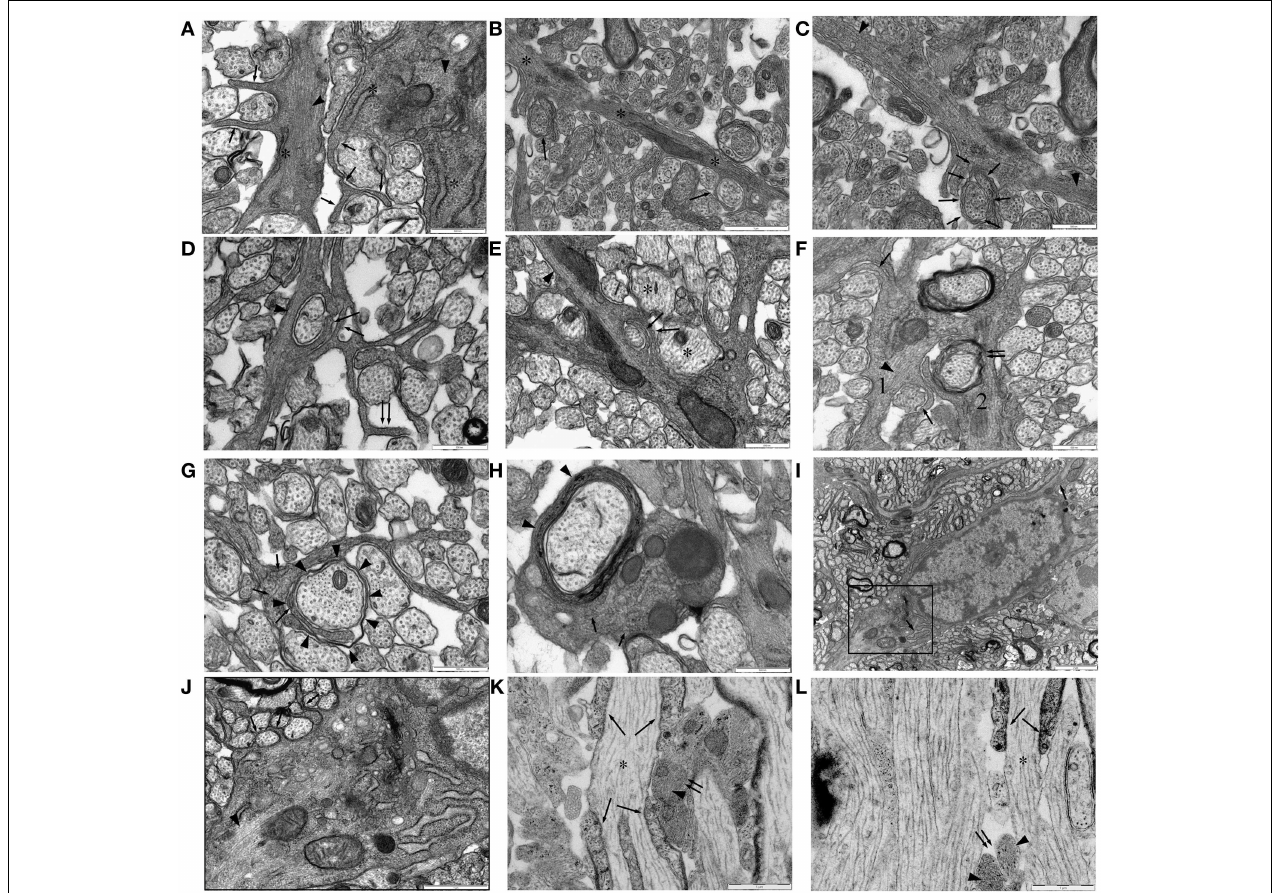
several small axons (e.g., dark arrows). Process “2” appears to have wrapped several layers around a larger axon (double arrows) and looks similar to “1” except that it contains no obvious filaments. (G) A glial processes containing neurofilaments, some oriented transversely (arrows) but no glial filaments, navigates between small diameter axons and has initiated wrapping of a large axon (arrow heads). (H) Oligodendrocyte processes showing multiple layers of myelin (arrow head) contain neurofilaments (arrows) but no glial filaments. Note the presence of glial filaments in neighboring glial processes. (I) Astrocyte somata, note the wide-bore ER (arrows) and the characteristic hetero-chromatin. The boxed area is shown at higher gain in (J) . (J) Note the glial filaments (arrow head) and the finger processes originating directly from the soma ensheathing small diameter axons (e.g., arrows). (K,L) Examples of long-section micrographs showing early myelination of a node of Ranvier in (K) and a hemi-node in (L) (“ * ”). Oligodendroglial processes navigate along the axon (arrows), and glial filament-filled (arrow heads) astrocyte processes cluster adjacent to the putative nodal membrane but do not wrap around it (double